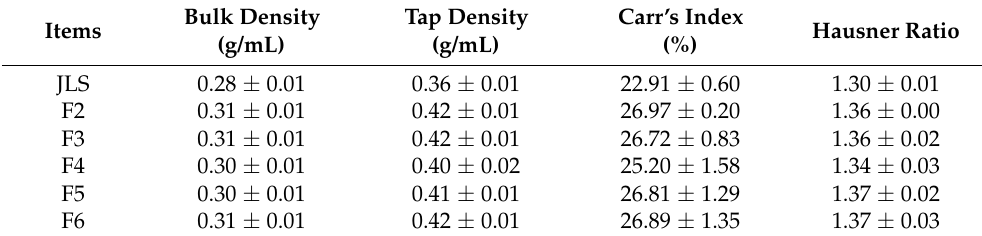
Table 5. Flowability of JLS and F2–6 granules ( n =